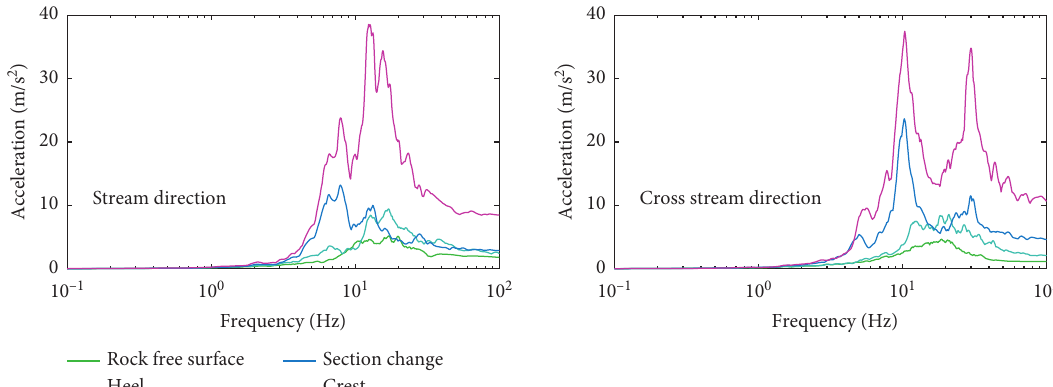
Figure 18: Response spectrum of acceleration time histories produced by the Swedish design earthquake at the middle of heel, section change, and crest of the dam in the (a) stream and (b) cross-stream direction with rock foundation modelling using the direct FE method.